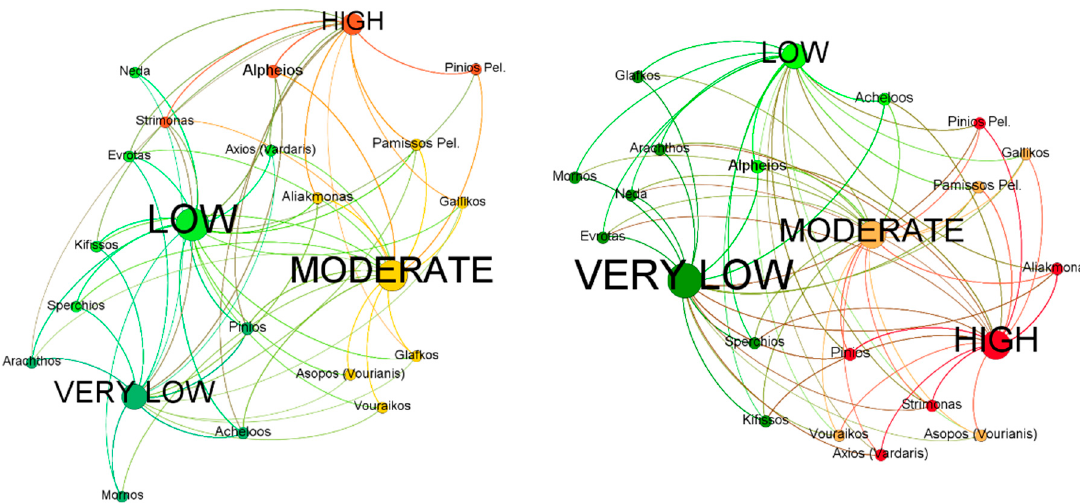
Figure 10. Network analysis of the examined Greek rivers based on the classification according to their total inorganic nitrogen loads ( left ) and inorganic phosphorus loads ( right ).